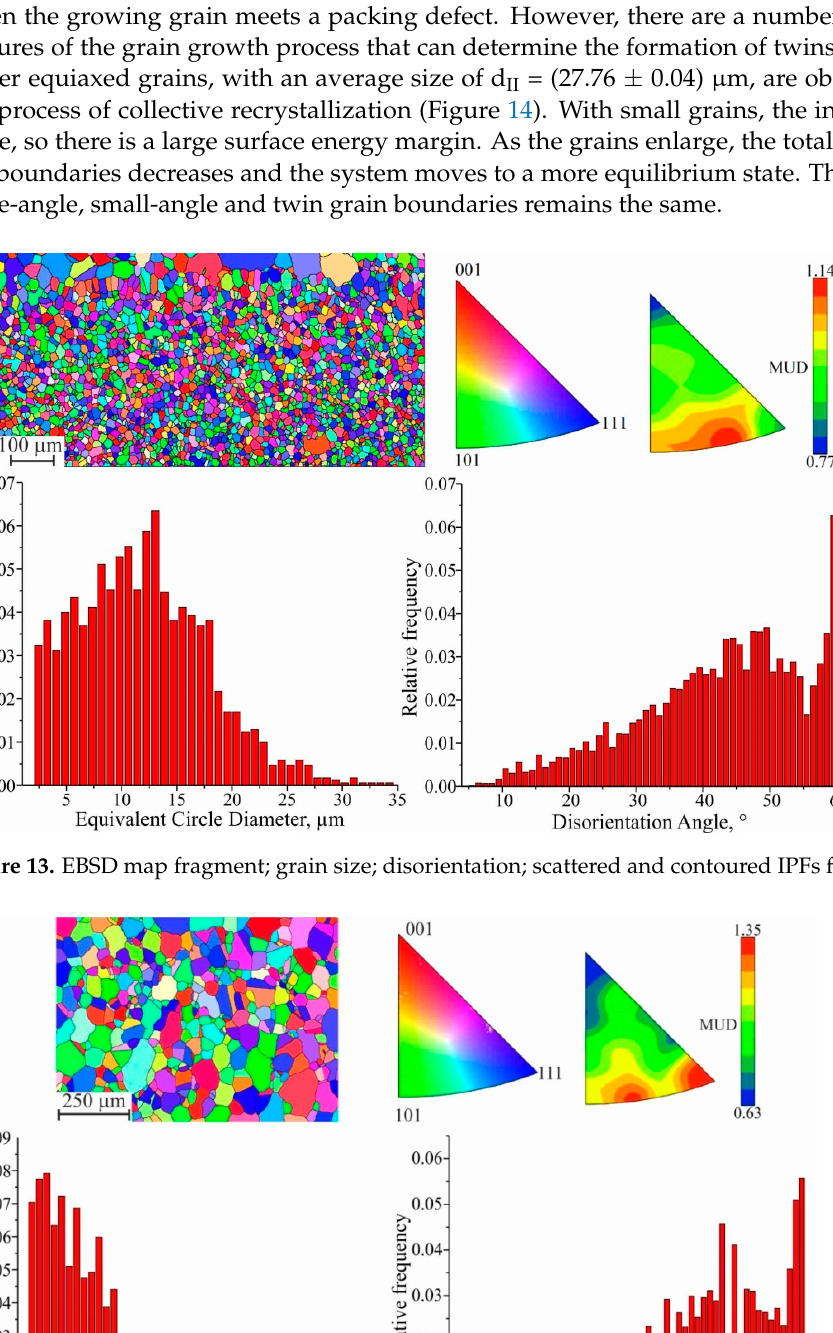
Figure 14. EBSD map fragment; grain size; disorientation; scattered and contoured IPFs for II area.